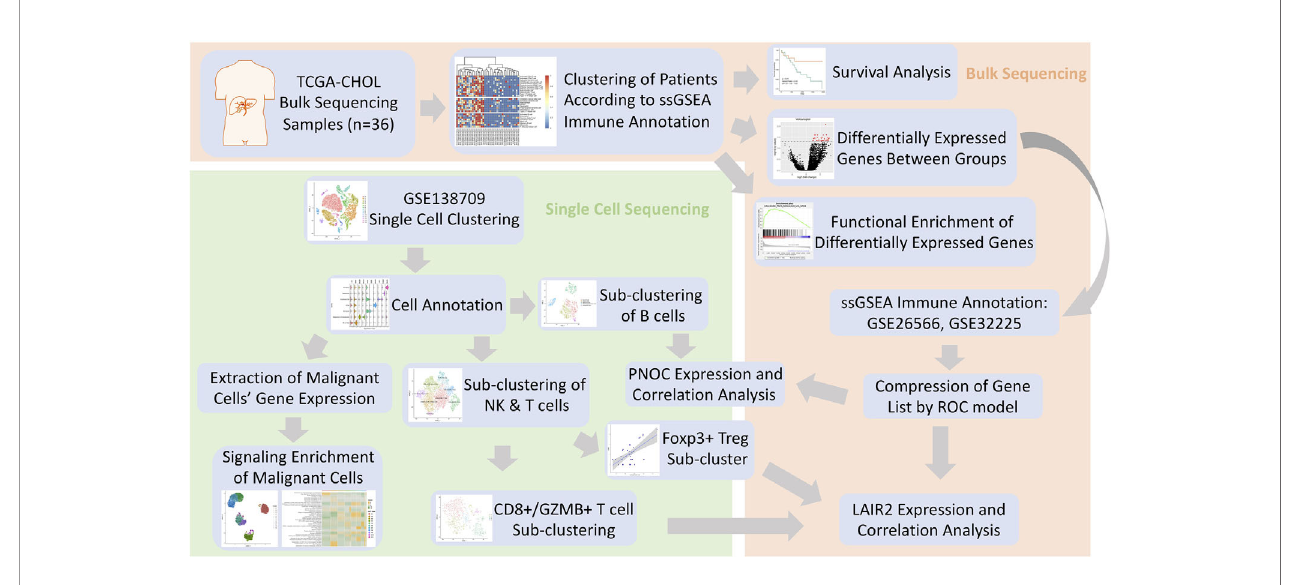
FIGURE 1 | Flowchart of